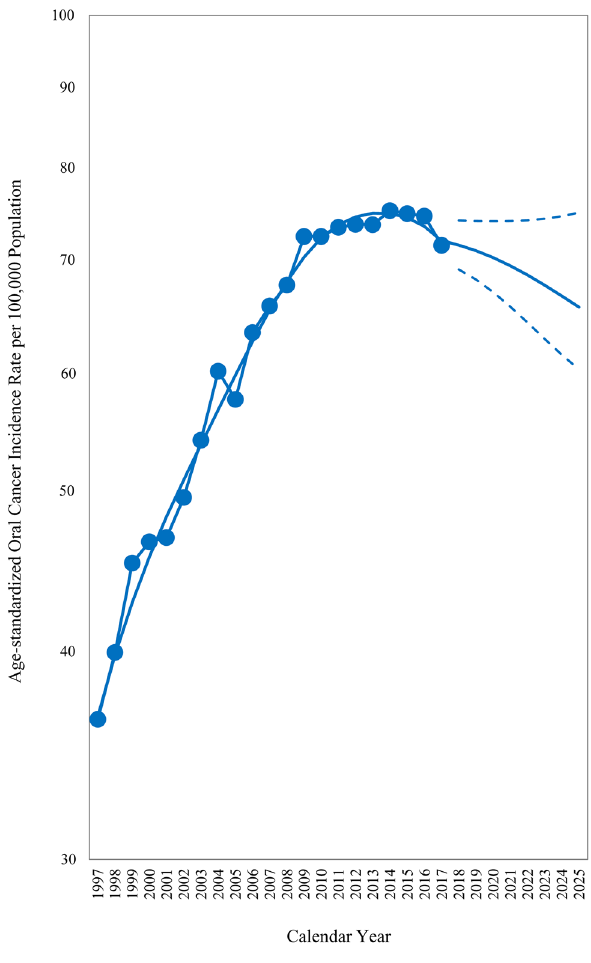
Figure 1. Age-standardized oral cancer incidence rates from 1997 to 2017 and the age–period–cohort model projections from 2018 to 2025. The World Health Organization 2000 Standard Population was used to compute the truncated age-standardized incidence rates (age range: 25–84 years), see Table